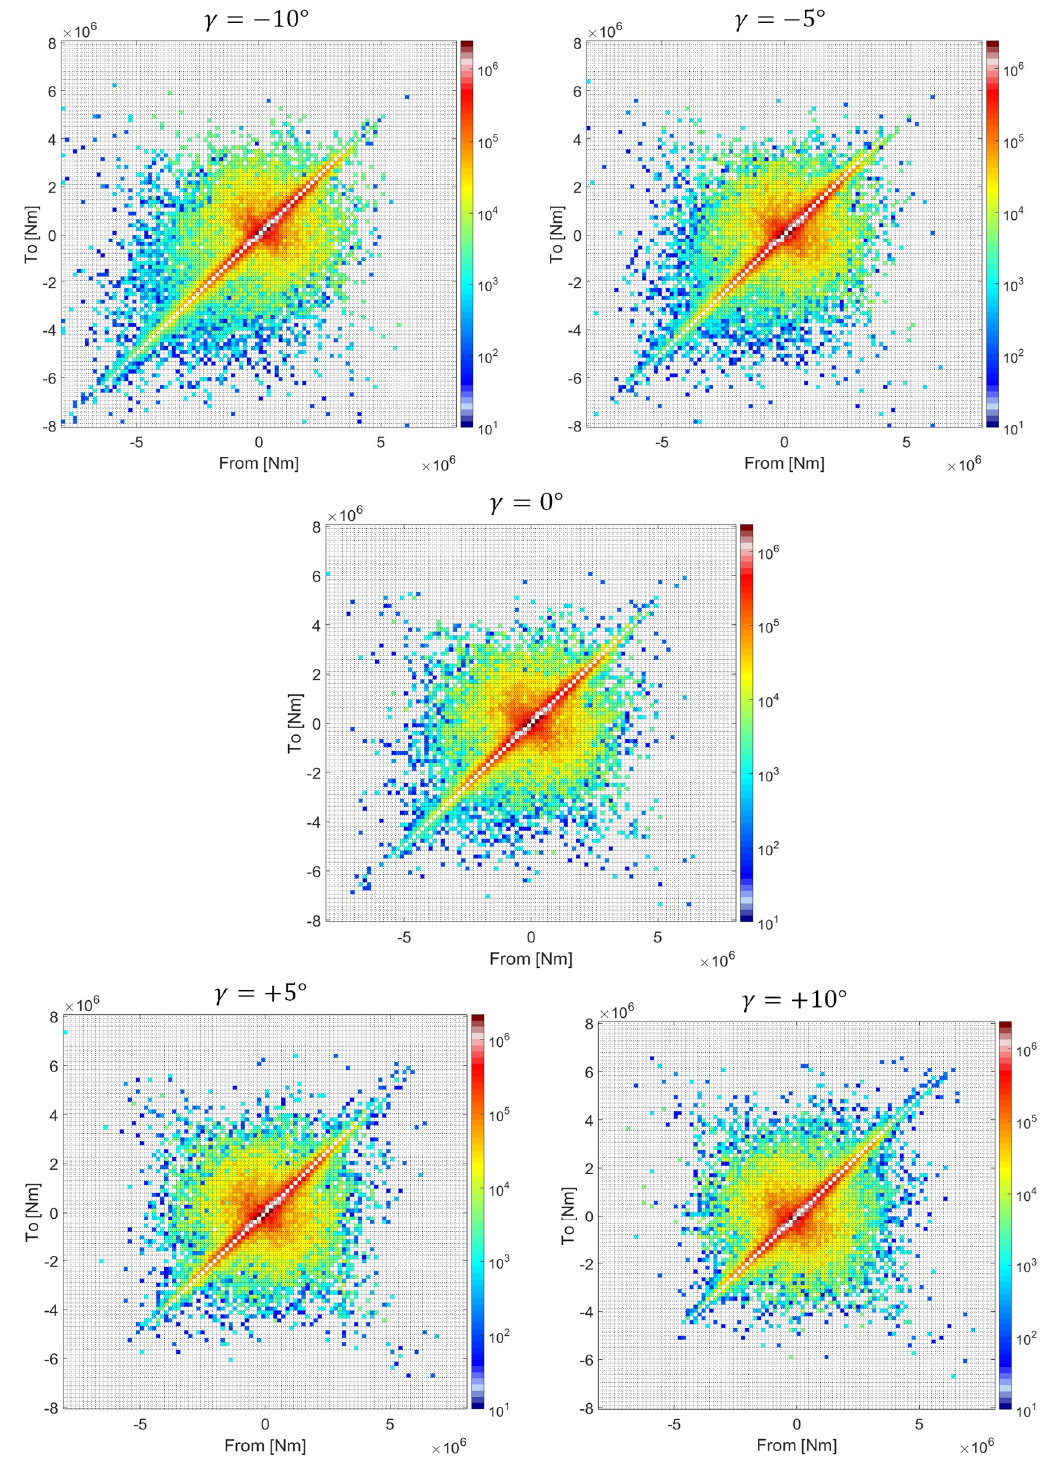
Figure 5. Rain flow count of the bending moment (around z‐axis) for various nacelle positions and a timespan of 20 years ( top left : −10°; top right : −5°; middle : 0°; bottom left : 5°; bottom right : 10°). Rain flow count diagrams of the torsional torque as well as the axial force (x-axis) and the in-plane vertical force (z-axis) were analysed. The torsional torque and the axial force show no qualitative dependency on the yaw misalignment which matches the results from the literature